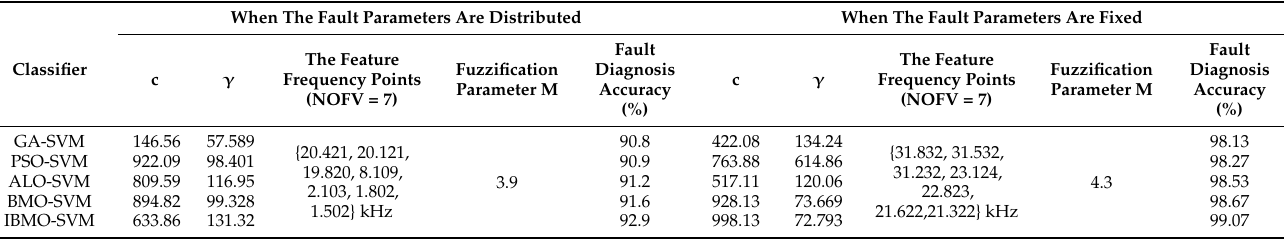
Table 7. Comparison of fault diagnosis